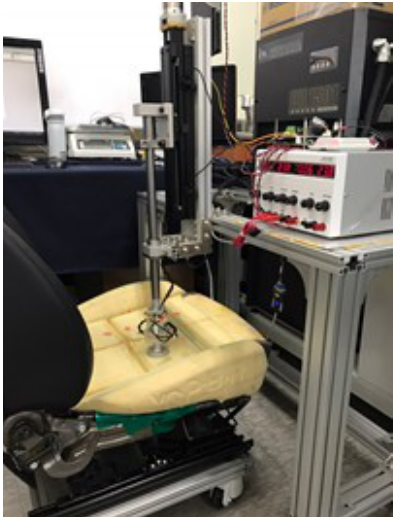
Figure 12. Elasticity measuring system.